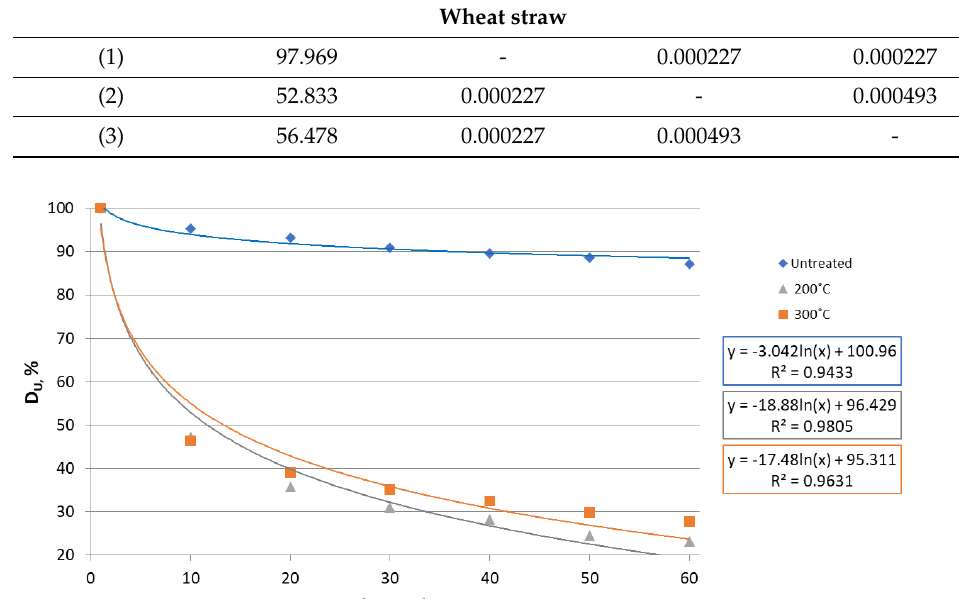
Figure 5. Mechanical durability of untreated and torrefied sunflower husk pellets.